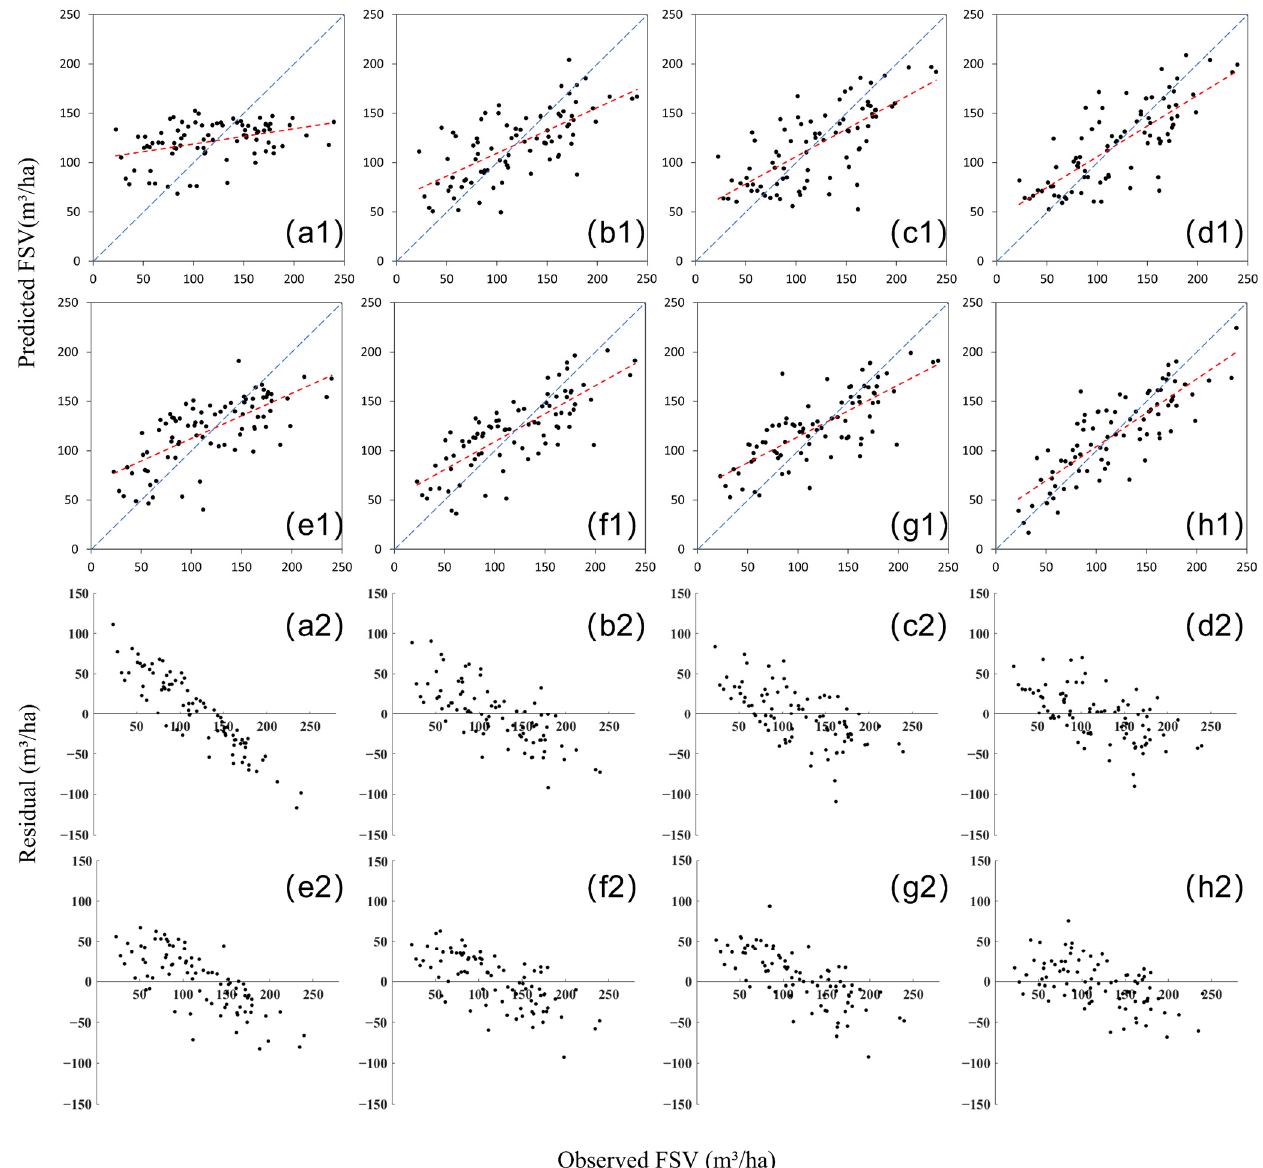
Figure 10. Scatterplots between ground measured and predicted FSV with optimal models: ( a1 – d1 ) illustrated the variables extracted from single LC8 images; ( e1 – h1 ) illustrated the variables extracted from composite LC8 images; ( a2 – h2 ) illustrated the plots between ground measured FSV and residuals from optimal results. The blue dashed line indicates the 1:1 reference line, and the red dashed line indicates the fitted